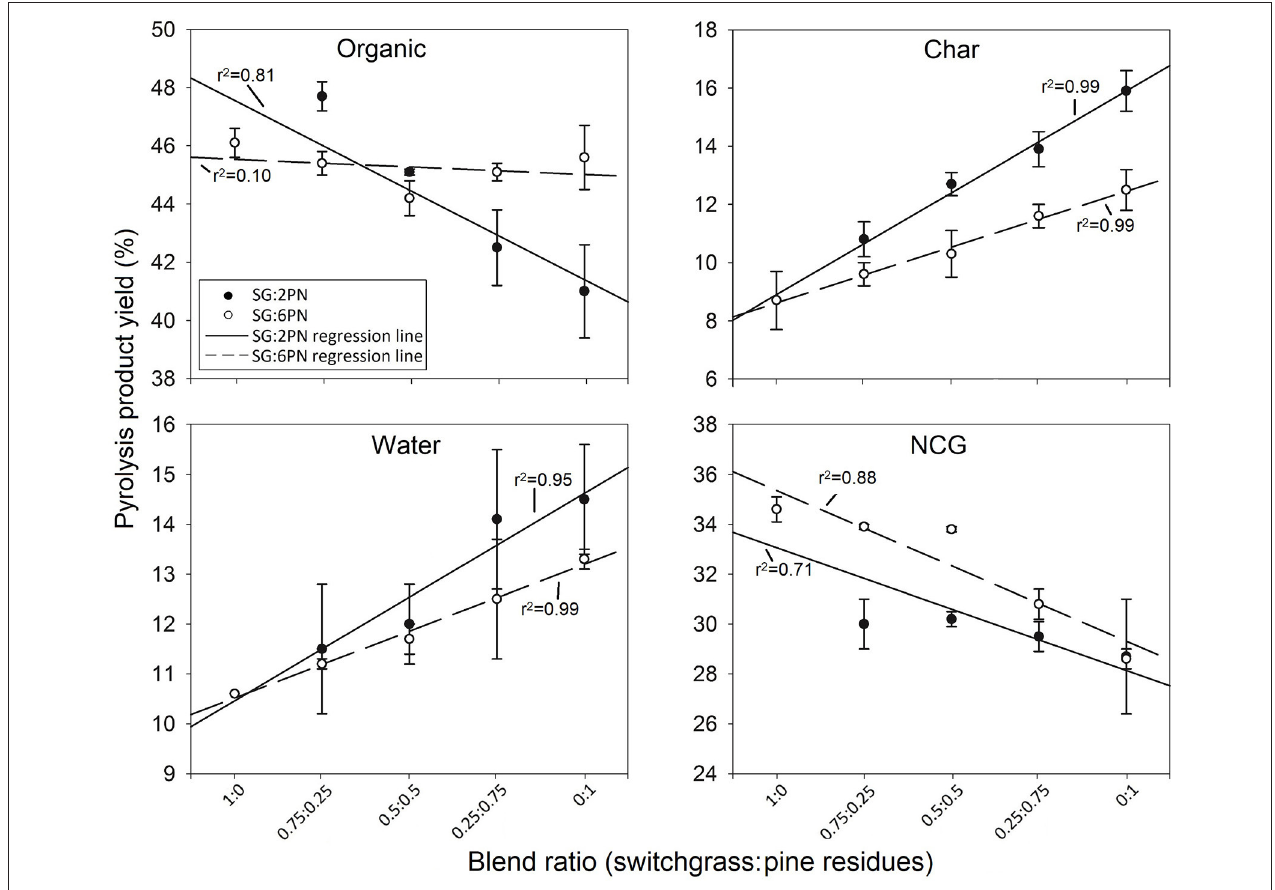
FIGURE 5 | Pyrolytic product yields of biochar, organic-phase bio-oil “organic,” water, and non-condensable gases (NCG) obtained by pure feedstocks and binary blends of switchgrass and pine residues.